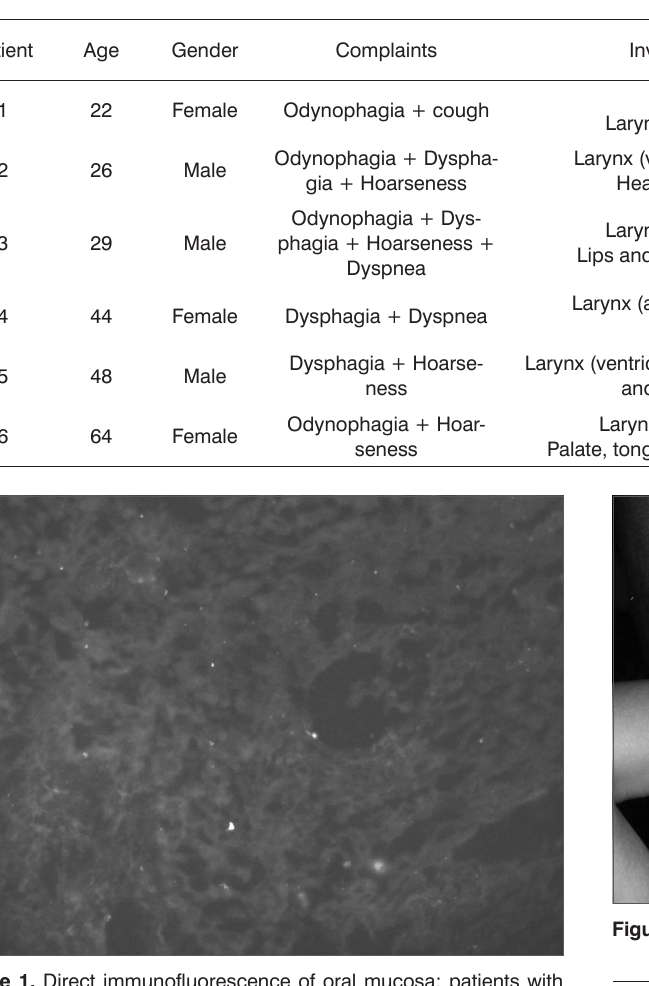
Figure 1. Direct immunofluorescence of oral mucosa: patients with atypical RAS - absent fluorescence.